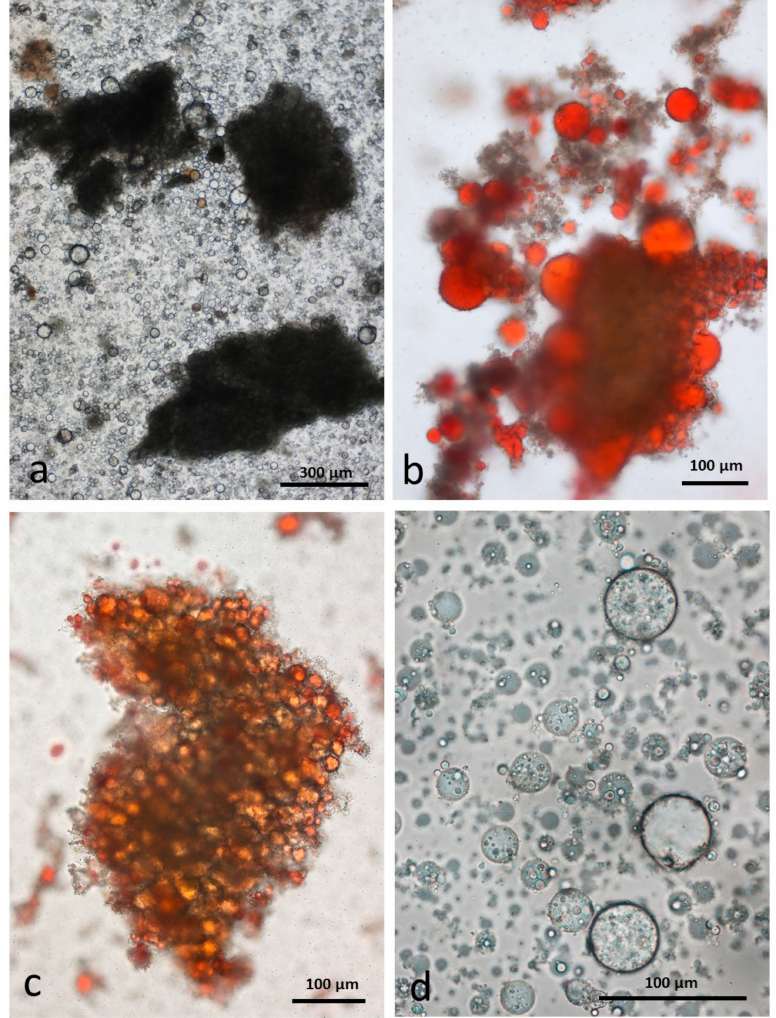
Figure 6. Chewed whole roasted almonds stored in CDTA: ( a ) multicellular particles of almond tissue surrounded by released lipid drops; ( b ) lipid drops stained with Sudan IV adhere to the particles; ( c ) lipid is released from oleosomes during roasting and coalesces within the undamaged cells; ( d ) many of the released lipid drops are in the form of a water-in-oil-in-water emulsion which persist during storage in